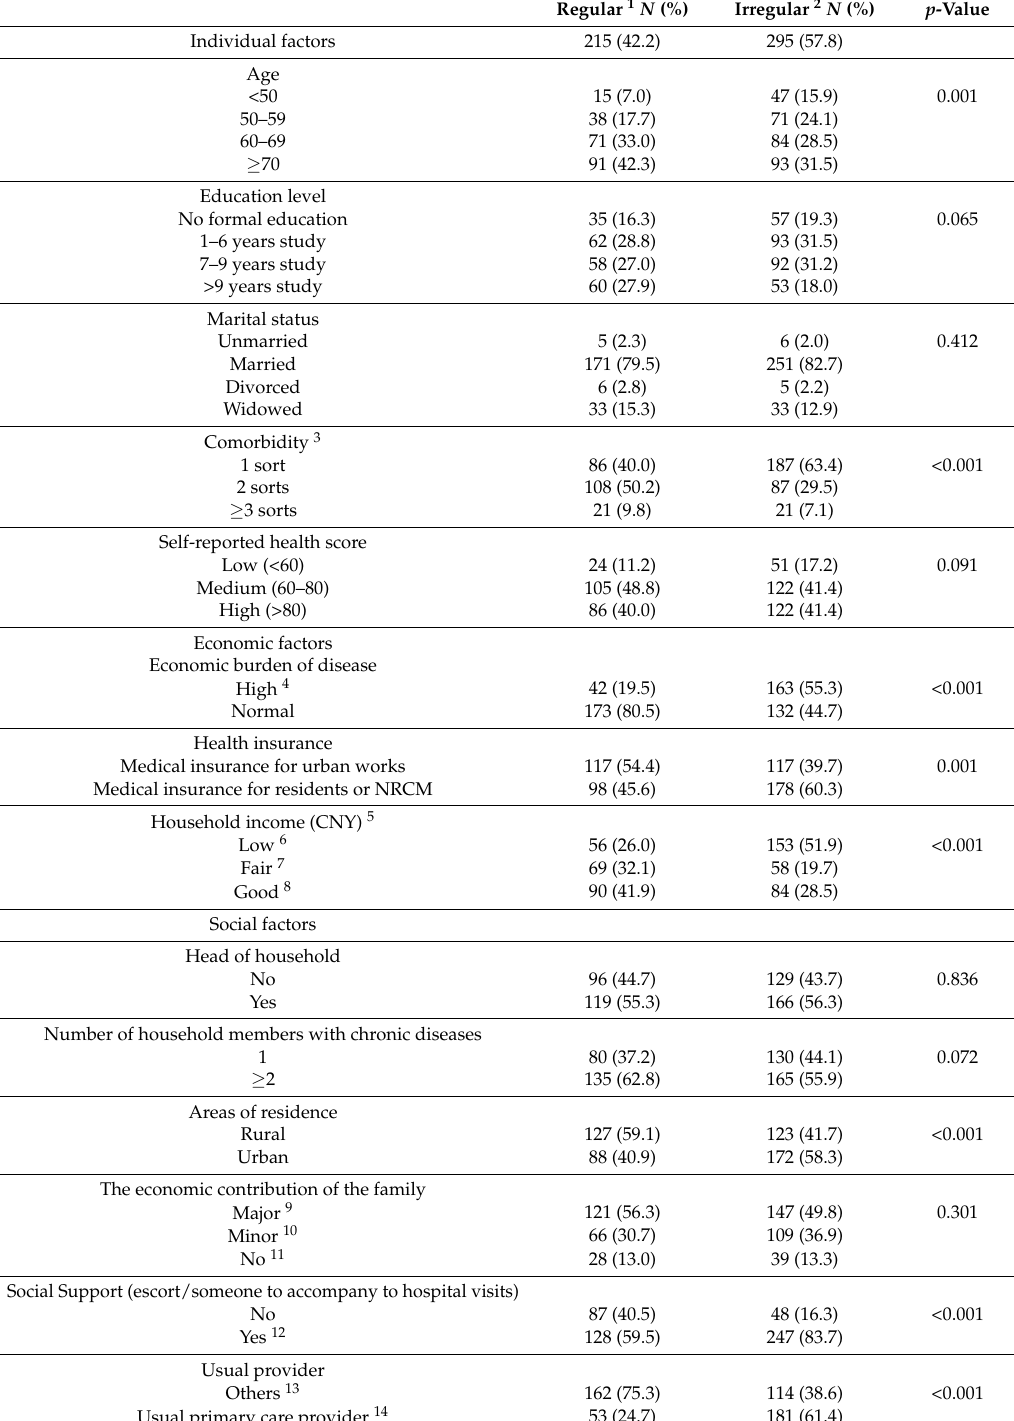
Table 2. Bivariate correlation of regularity of patients with hypertension or diabetes seeking health